Question: From the figure, is the trend upward or downward?
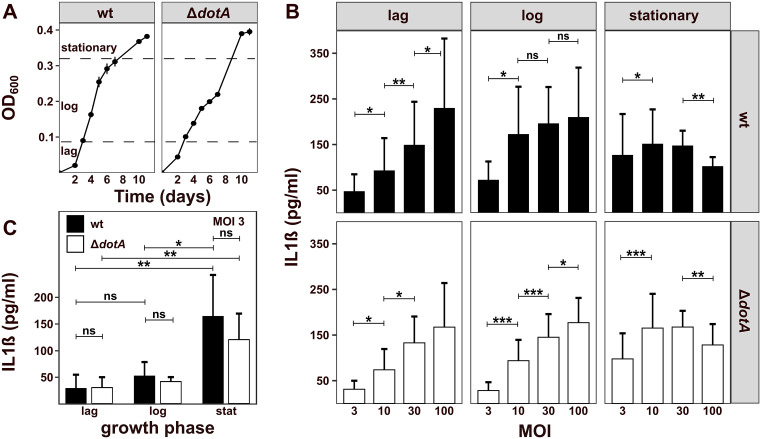
Answer: increasing